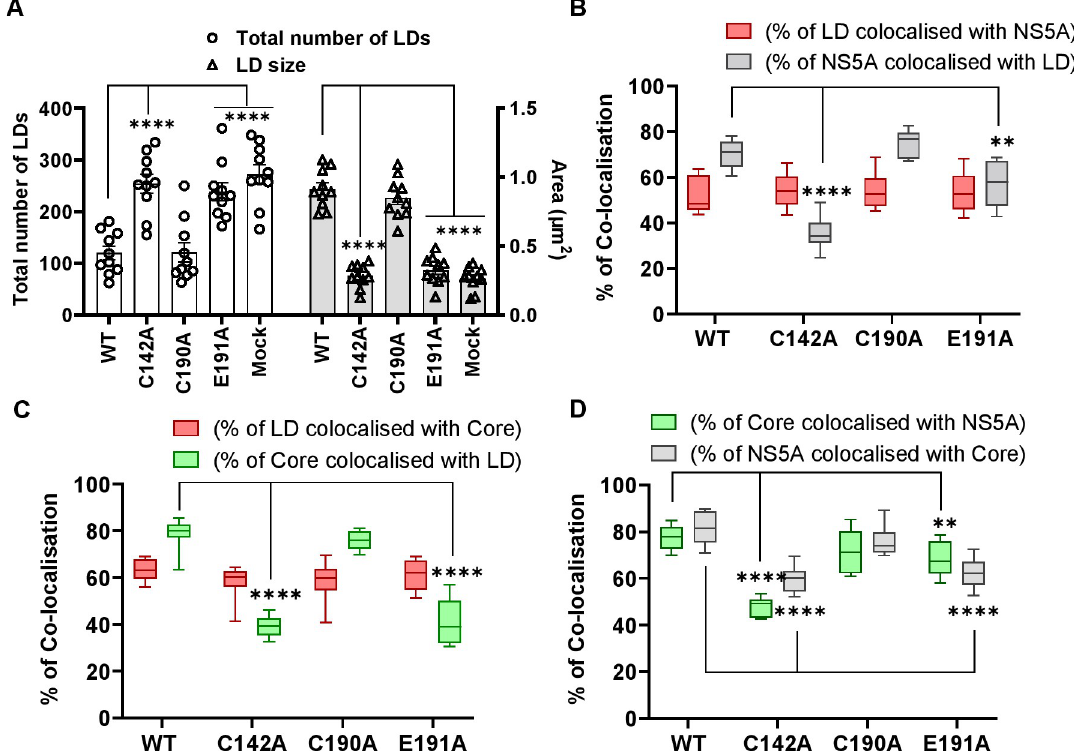
Fig 4. Quantification of LD size and co-localisation with NS5A and Core. (A) LD numbers and size in cells from Fig 3 were calculated using Analyze Particles module of Fiji. Mock: uninfected Huh7.5 cells. 10 cells were analysed for each sample. ( B) Quantification of the percentage of LD colocalized with NS5A (red), and NS5A colocalized with LD (grey). ( C) Quantification of the percentage of LDs colocalized with Core (red), and Core colocalized with LD (green). ( D ) Quantification of the percentage of Core colocalized with NS5A (green), and NS5A colocalized with Core (grey). Co-localisation was analyzed in 10 cells for each construct using Fiji. Significant differences from WT denoted by �� (P < 0.01) and ���� (P < 0.0001).